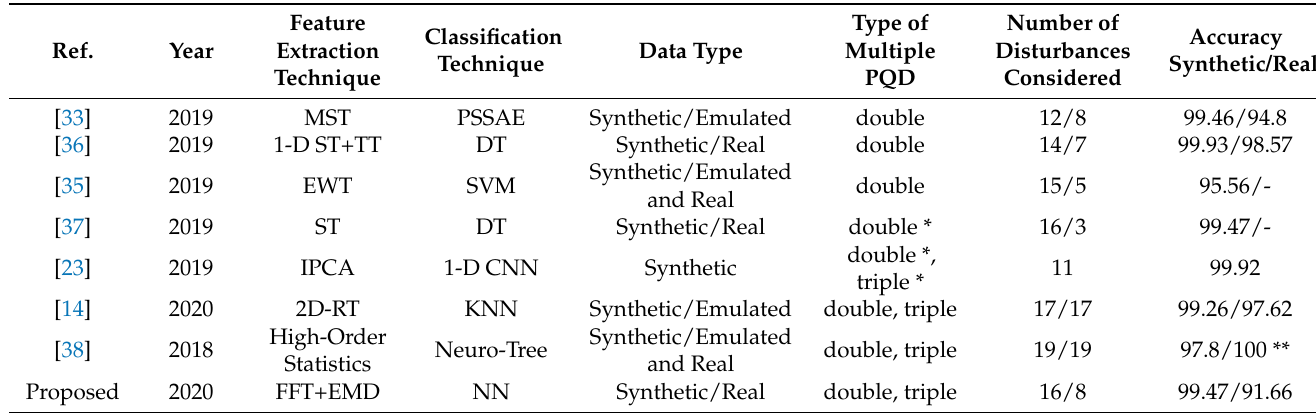
Table 5. Performance comparison with recent